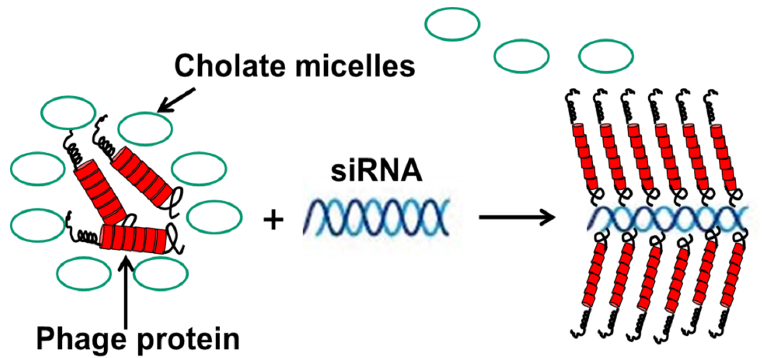
Figure 9. Preparation of nanophages from fusion phage protein and siRNA. The complex is formed during removal of protein-stabilizing cholate buffer. After the removal of cholate, the complex of RNA and protein is stabilized as a result of (a) the hydrophobic interaction of protein subunits, and (b) electrostatic interaction of positively charged C-terminus of the major coat protein and negatively charged phosphates of siRNA. Displayed N-terminus of phage protein serves as targeting ligand, which brings siRNA into the breast cancer cells. Adapted from [86].